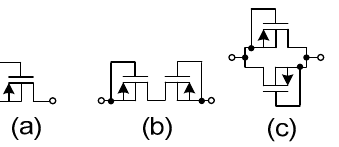
Figure 2. Nontunable pseudo-resistors. ( a ) Single PMOS device. ( b ) Series topology. ( c ) Parallel topology.